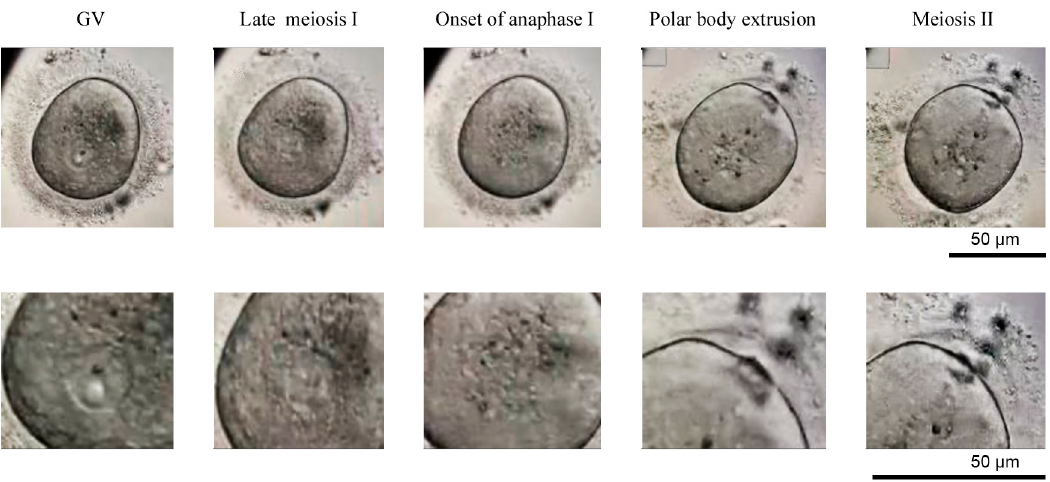
Figure 5. Sequence at different stages of meiosis of the human oocyte. Oocyte with an intact nucleus (prophase I, GV), late metaphase of meiosis I, onset of anaphase I, onset of polar body extrusion and meiosis II, total polar body extrusion. Images were obtained in Primo Vision Time-Lapse System (Vitrolife ® Göteborg, Sweden) in the Human Reproduction Unit of Hospital Universitario y Politécnico, La Fe.